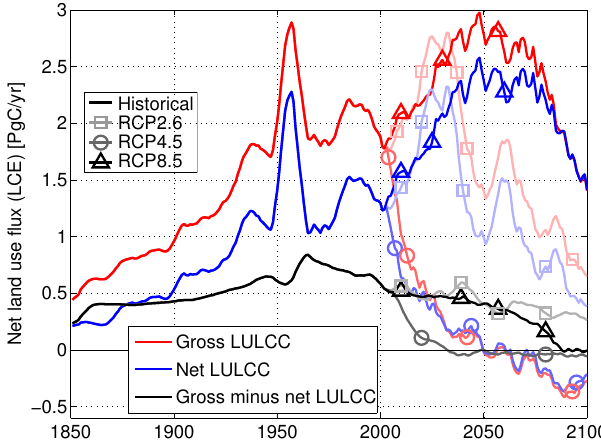
Figure 3. Seven-year running mean of land-use carbon emissions from gross and net transitions as well as the difference between them.